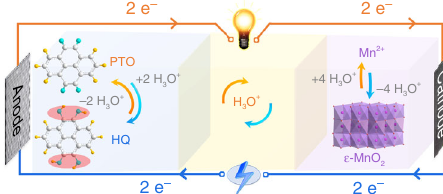
Fig. 1 Schematic illustration of working mechanism for the PTO// MnO 2 @GF hydronium-ion